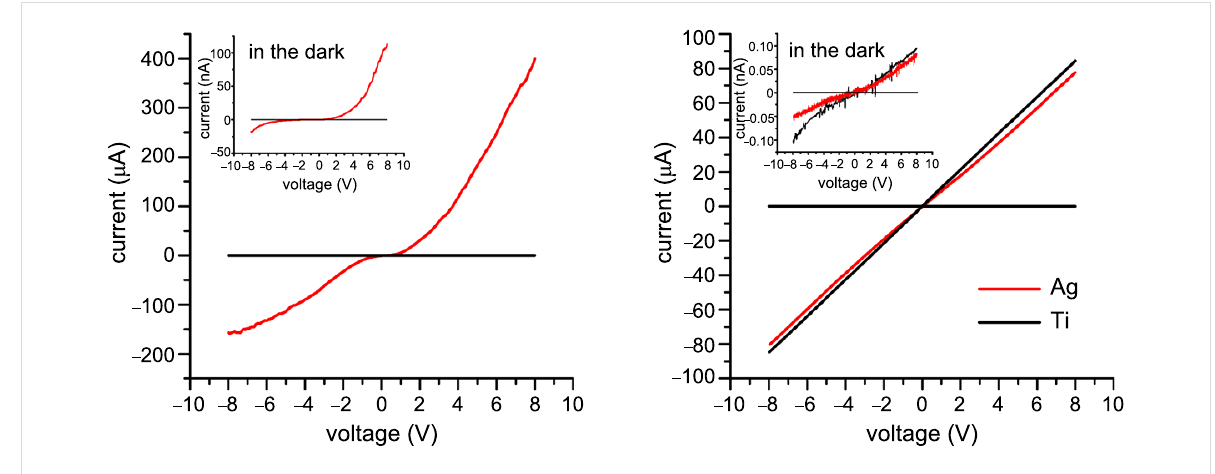
Figure 3: I–V curves of ZnO nanowire films under UV illumination and in the dark. (a) The device in PDMS with Ag–PDMS paste electrodes; (b) two devices in air, with vacuum-deposited metal electrodes (Ti or Ag).